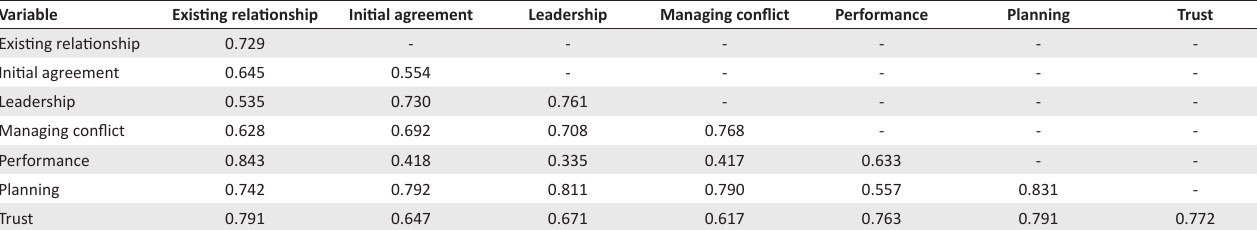
TABLE 1: Discriminant validity: heterotrait–monotrait ratio of correlations. Variable